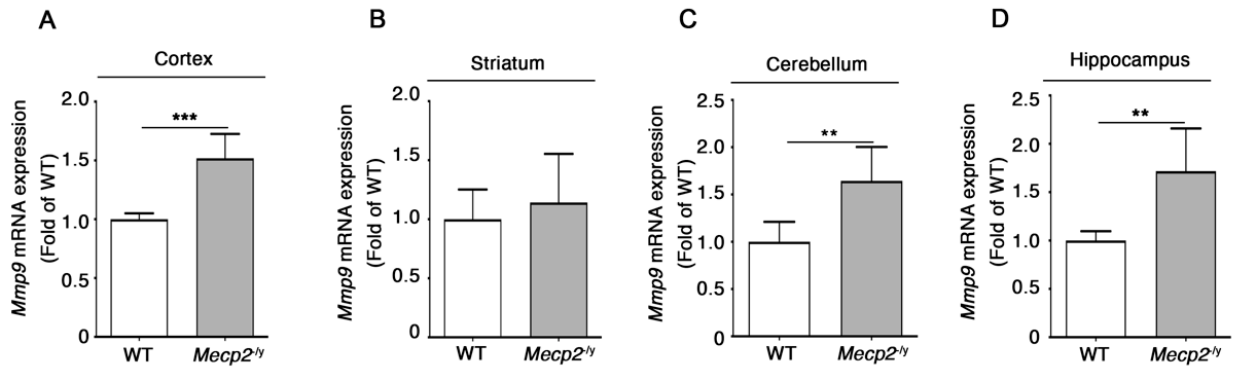
Figure 5. The expression of Mmp9 is up-regulated in the brain of Mecp2 -/y mice. qPCR analysis of Mmp9 in cortex ( A ), striatum ( B ), cerebellum ( C ), and hippocampus ( D ) of Mecp2 -/y and age-matched WT mice. Data were normalized to Gapdh. Values are represented as mean ± SD. N = 6 for each group of mice. **, p < 0.01, ***, p < 0.001 (two-tailed unpaired t -test).